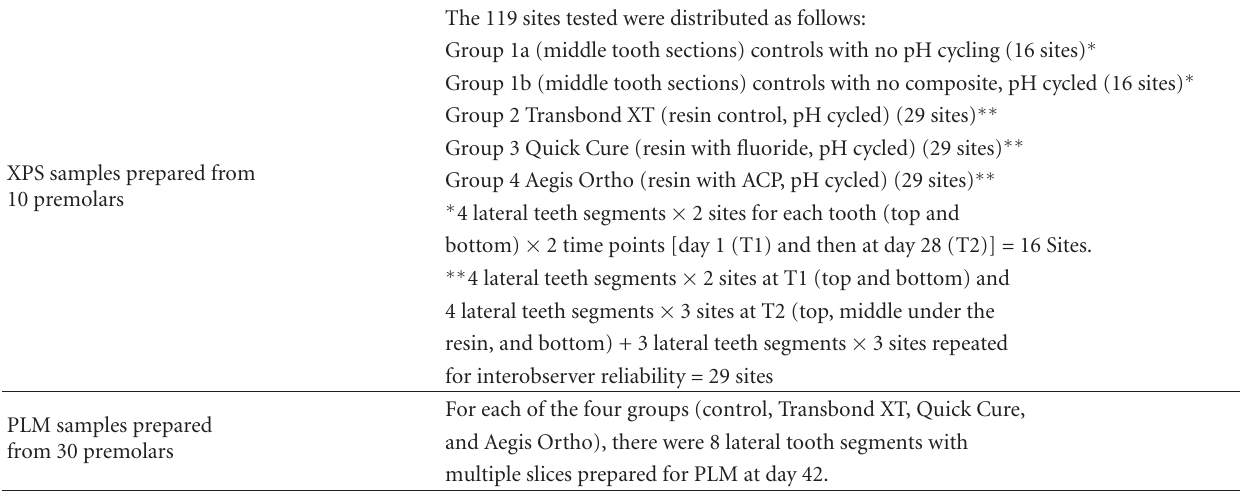
Table 1: Details of sample numbers.